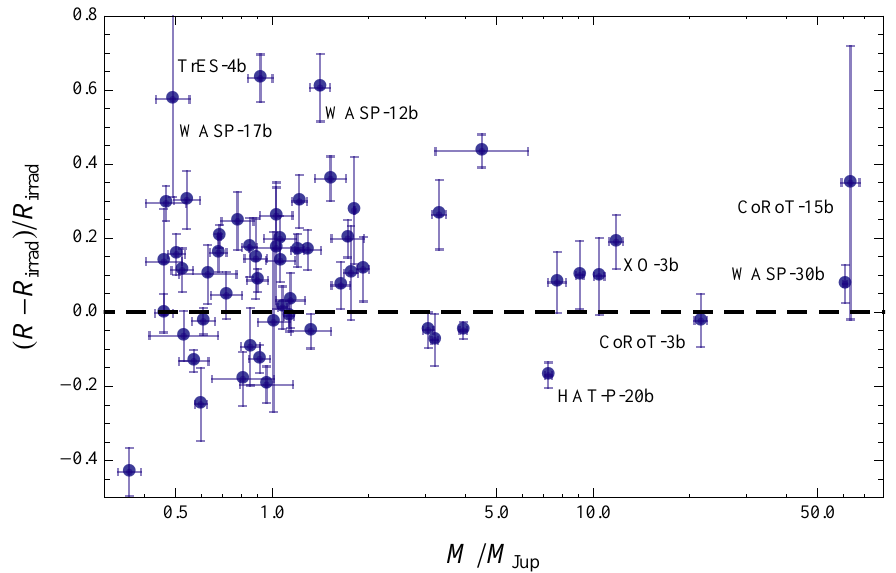
Figure 1: Relative radius excess between the observationally and the theoretically deter- mined values for 57 transiting systems 1 . Objects significantly above the dashed line